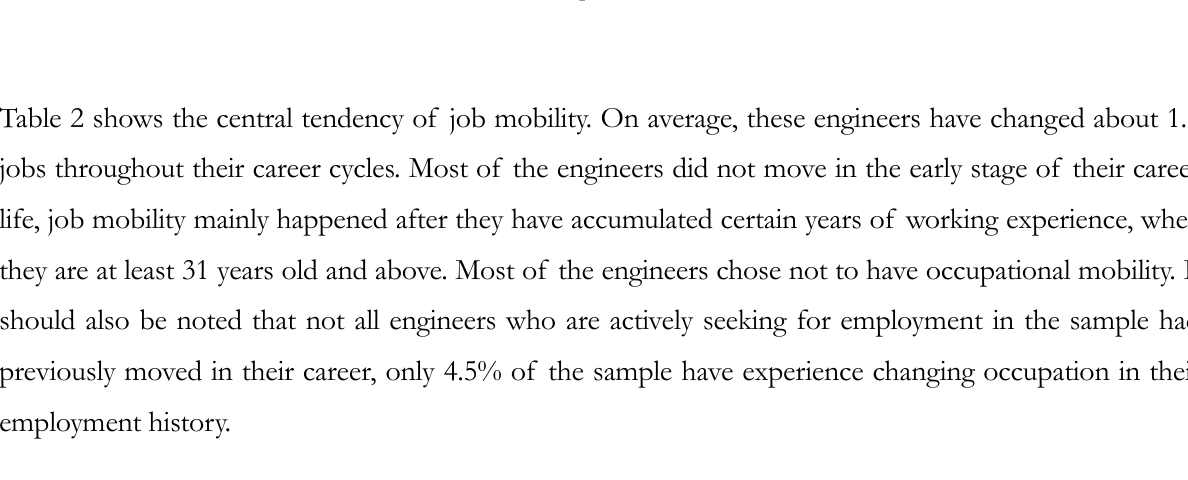
Table 1. Sample characteristics